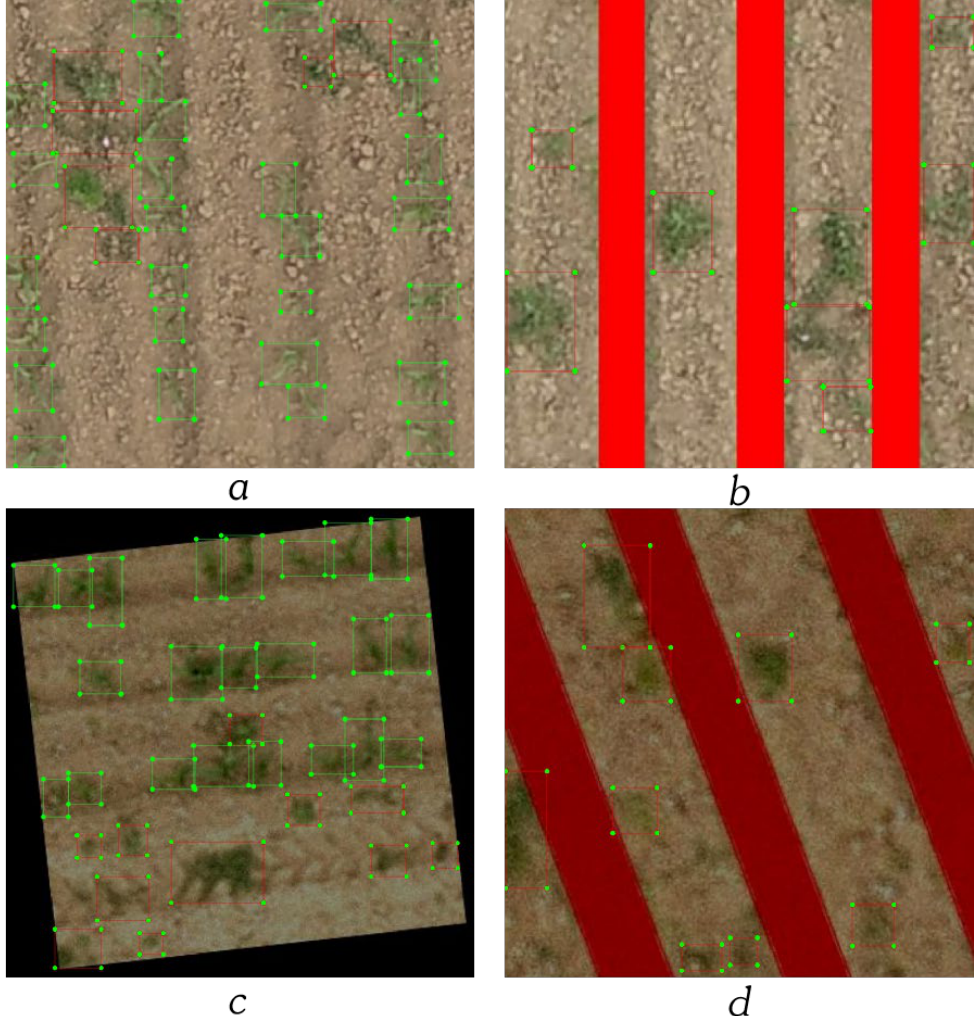
Figure 6. Examples of different forms of sample labeling, where the green label box is maize and the red label box is weed. ( a ) The original image was labeled with maize and weed; ( b ) the masked image was labeled with weed; ( c ) data augmentation of the original image, and ( d ) data augmentation of the masked image.